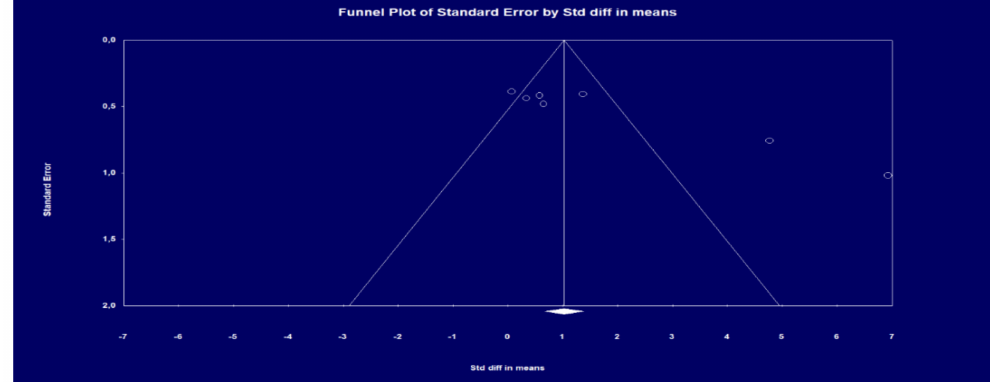
Figure 3. Funnel scatter plot to check publication